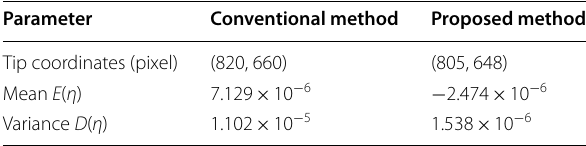
Table 6 Relative errors of proposed and conventional methods